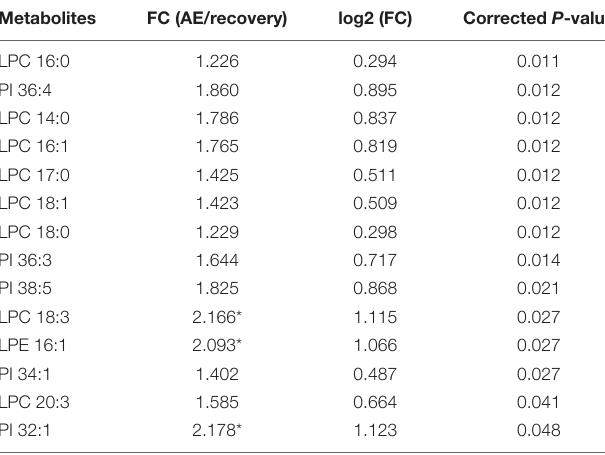
TABLE 2 | List of differential metabolites in the AE and recovery